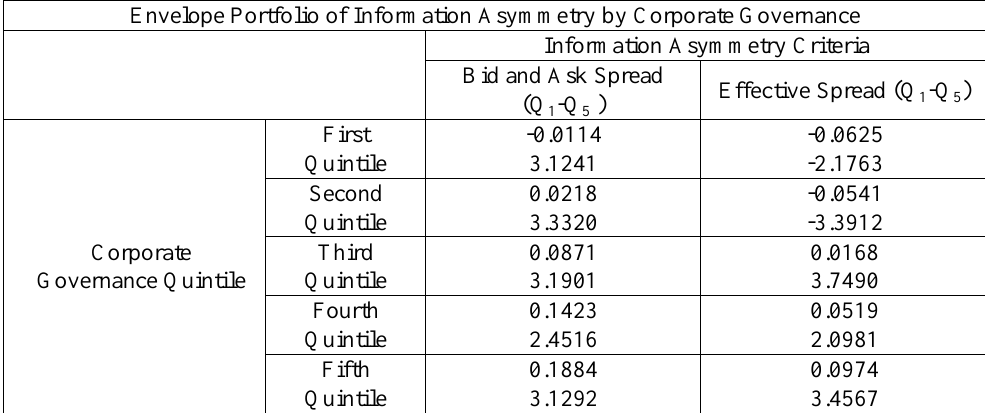
Table 8. Envelope portfolio of information